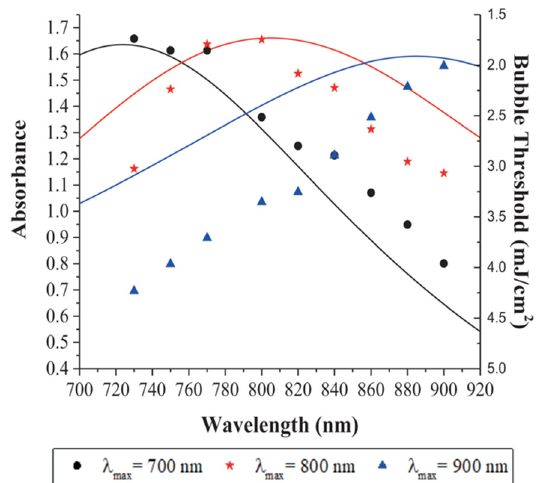
Figure 12. Solid lines show the optical absorption spectra of 20 nm HGN with different wall thick- nesses with λ max of 700 nm (black line), 800 nm (red line), and 900 nm (blue line). The nanobubble threshold fluence is smallest when the irradiating wavelength coincides with λ max of the HGN. Black circles give the threshold fluence for λ max = 700 nm, red stars for λ max = 800 nm, blue triangles for λ max = 900 nm for different irradiation wavelengths. The minimum threshold fluence is ~ 2 mJ cm − 2 when irradiated at λ max for all HGN. For irradiating wavelengths (cid:54) = λ max , the fluence to initiate nanobubble generation increases rapidly. Adapted from [45], published by Wiley, 2018.